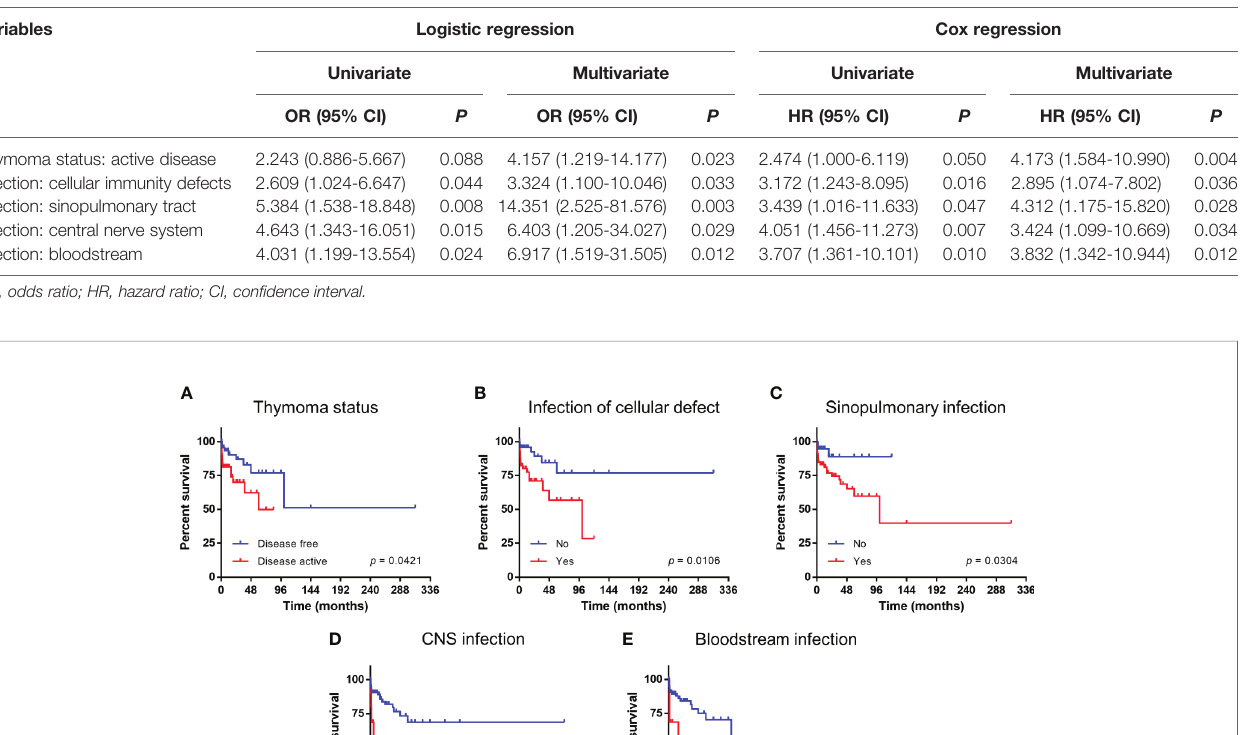
TABLE 2 | Univariate and multivariate analyses of factors impacting outcomes.